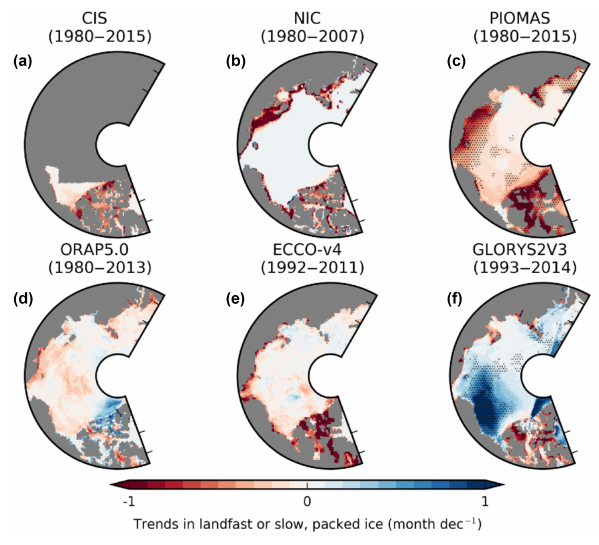
Figure 3. (a) Same as Fig. 2b. (b) – (f) Same as Fig. 2d–h except for a subset of simulations from the CMIP5 RCP8.5 scenario over the period 1980–2015.